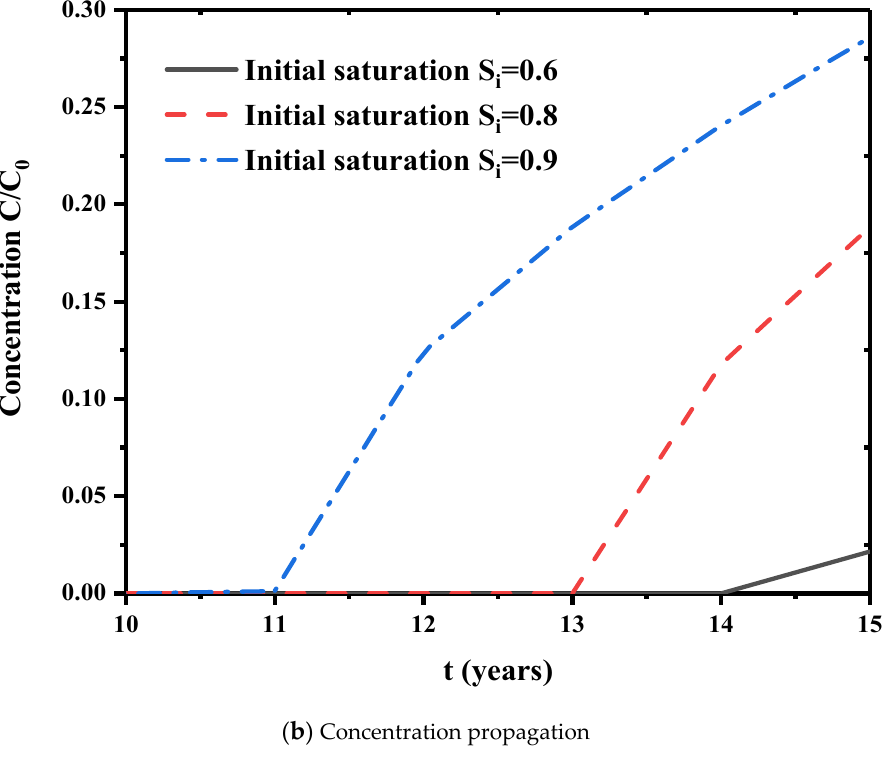
Figure 11. Effects of initial saturation on displacement change and concentration propagation. (( a ) Displacement change. ( b ) Concentration propagation.).